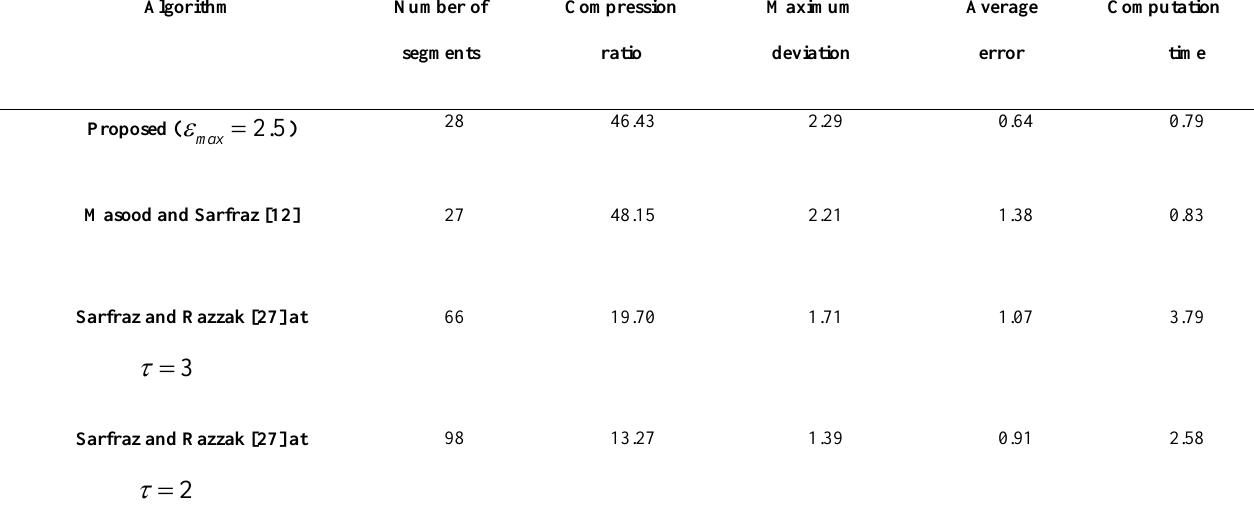
Table 3. Results of quantitative performance with different algorithms for the outline of Arabic word "Sabr".